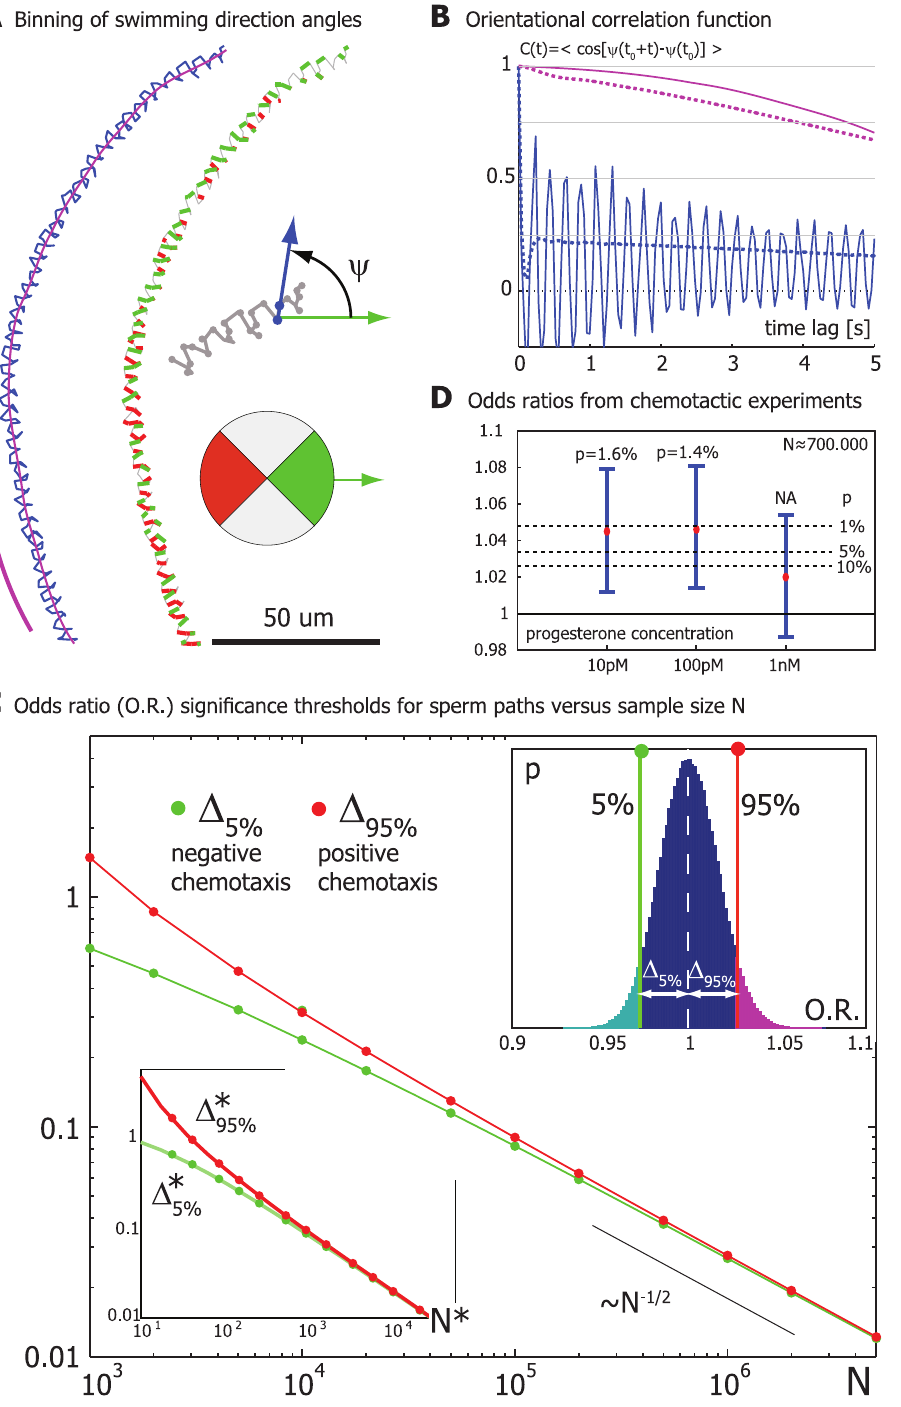
Figure 1. Directional persistence of sperm swimming paths prompts adapted statistical test for motion bias. A. One out of 30,000 control human sperm tracks (blue) and the corresponding averaged swimming path (purple; computed using a second-order Savitzky-Golay filter). The fast wiggling of the sperm head center is clearly visible. For later odds ratio calculations, angles y between a preferred direction and the frame- to-frame displacement vectors were binned according to the color wheel shown; the color-coded track illustrates the binning. B. Orientational correlation function C ( t ) of the swimming direction angle y for the sperm track from panel A (solid blue). This correlation function shows fast oscillations resulting from periodic head wiggling as well as slow decay on a time-scale of several seconds, which reflects directional persistence of sperm swimming. Also shown is a sample average of this autocorrelation (dotted blue) computed by averaging individual angle autocorrelation functions from n =4,000 long sperm tracks (duration . 10 sec). We can further define an analogous angle autocorrelation function for the direction angle of the averaged path (solid purple: for the averaged path from panel A; dotted purple: sample average). C. Empirical significance thresholds for the odds ratio of swimming direction angles for a human sperm population assay: An odds ratio O.R.=( N + / N 2 )/( N + 0 / N 2 0 ) greater than 1 + D 95% ( N ) with sample size N =min( N + + N 2 , N + 0 + N 2 0 ) should be statistically significant for positive chemotaxis at a 5%-confidence level. The test for negative